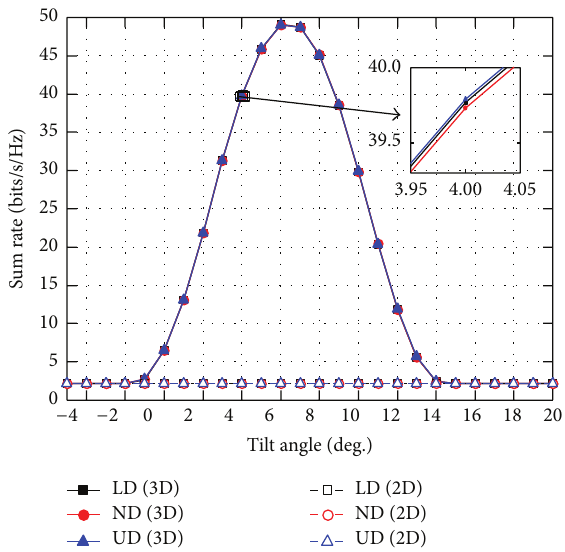
Figure 4: Simulated sum rate against tilt angle for three user distributions ( 𝑝 𝑢 = 5 dB, 𝑁 𝑟 = 50 , 𝑁 𝑡 = 2 , 𝐿 = 3 , 𝐾 = 24 , 𝐷 = 1000 m, 𝑅 = 100 m, 𝜐 = 4 , UD: uniform distribution, ND: normal distribution, and LD: linear